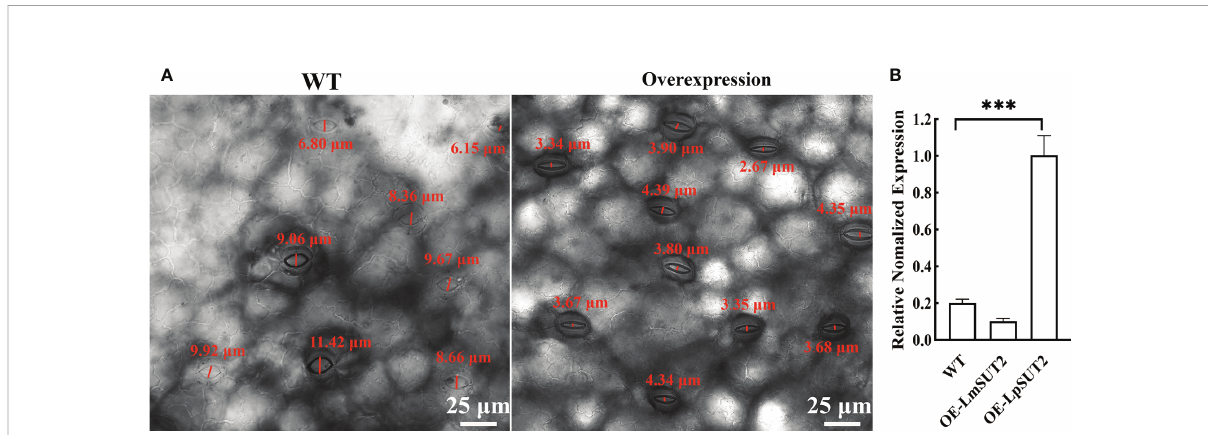
FIGURE 5 Effects of LpSUT2 on the stomata and analysis of LpSUT2 expression. The stomatal aperture of overexpressed lines decreased compared with that of WT (A) . Quanti fi cation of LmSUT2 and LpSUT2 mRNA accumulation is done by qRT-PCR analysis under a 16 h light/8 h dark cycle with a photon fl ux density of 100-120 m mol -2 s -1 at a temperature cycle of 25°C/15°C (day/night) and is cultured for one week (B) . Figure 5B showed as mean values±SD of three independent experiments (***P value<0.001). Scale bars: 25 m m in (A) . WT, Wild type; OE, Overexpression; LmSUT2, Sucrose transporter 2 of Lemna minor ; LpSUT2, Sucrose transporter 2 of L. punctata